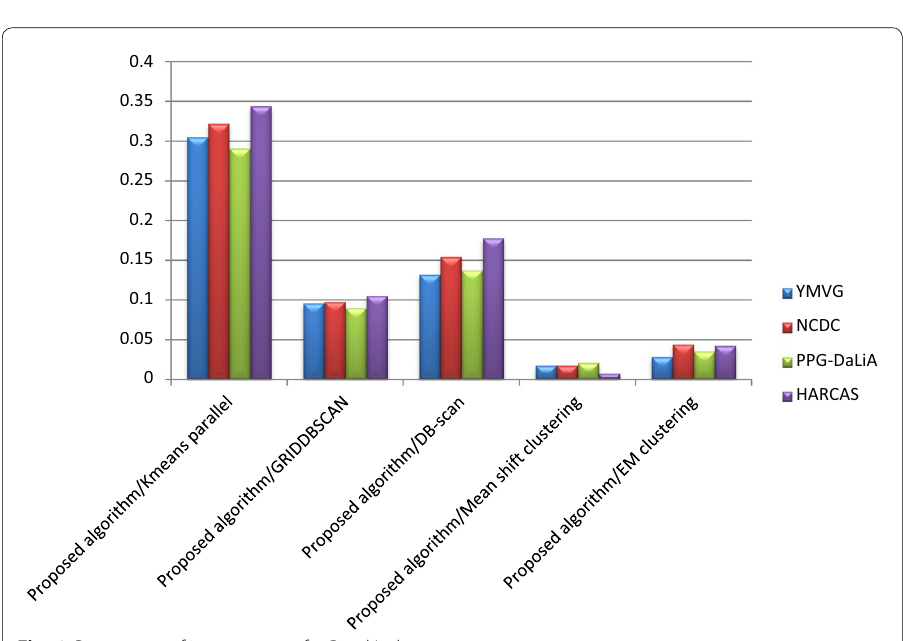
Fig. 6 Percentage of improvement for Rand